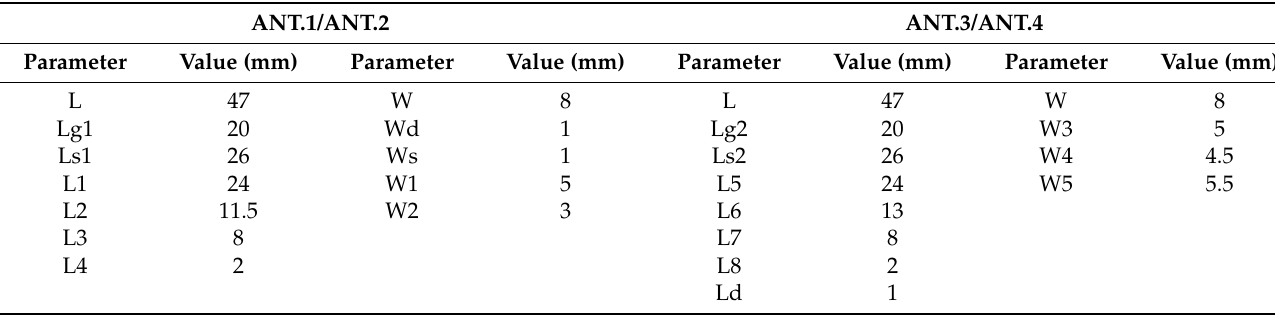
Figure 11. Ant. 1 and Ant. 3 for the final proposed design. Table 1. Detailed Antenna